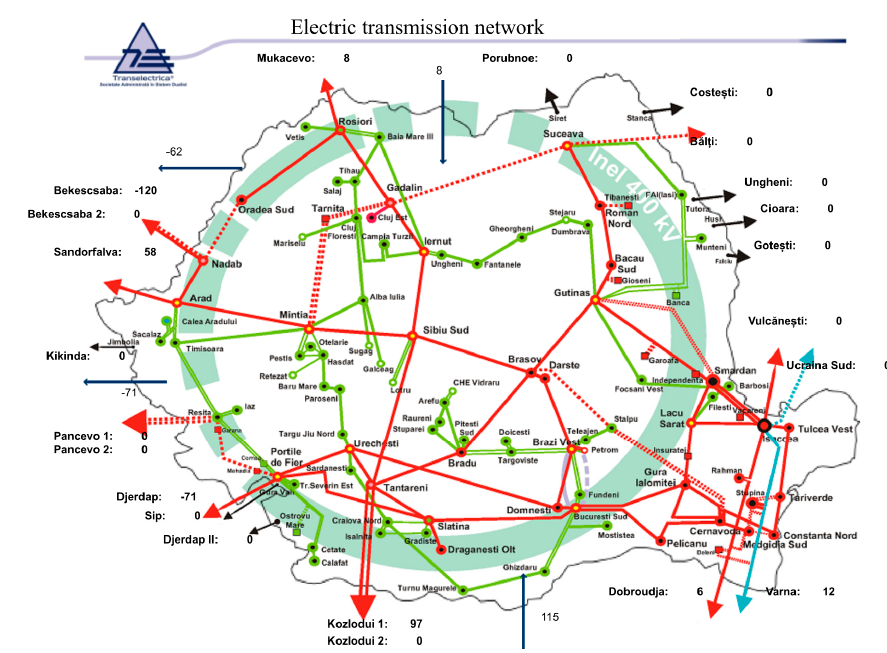
Figure 3. Electric transmission network [14].